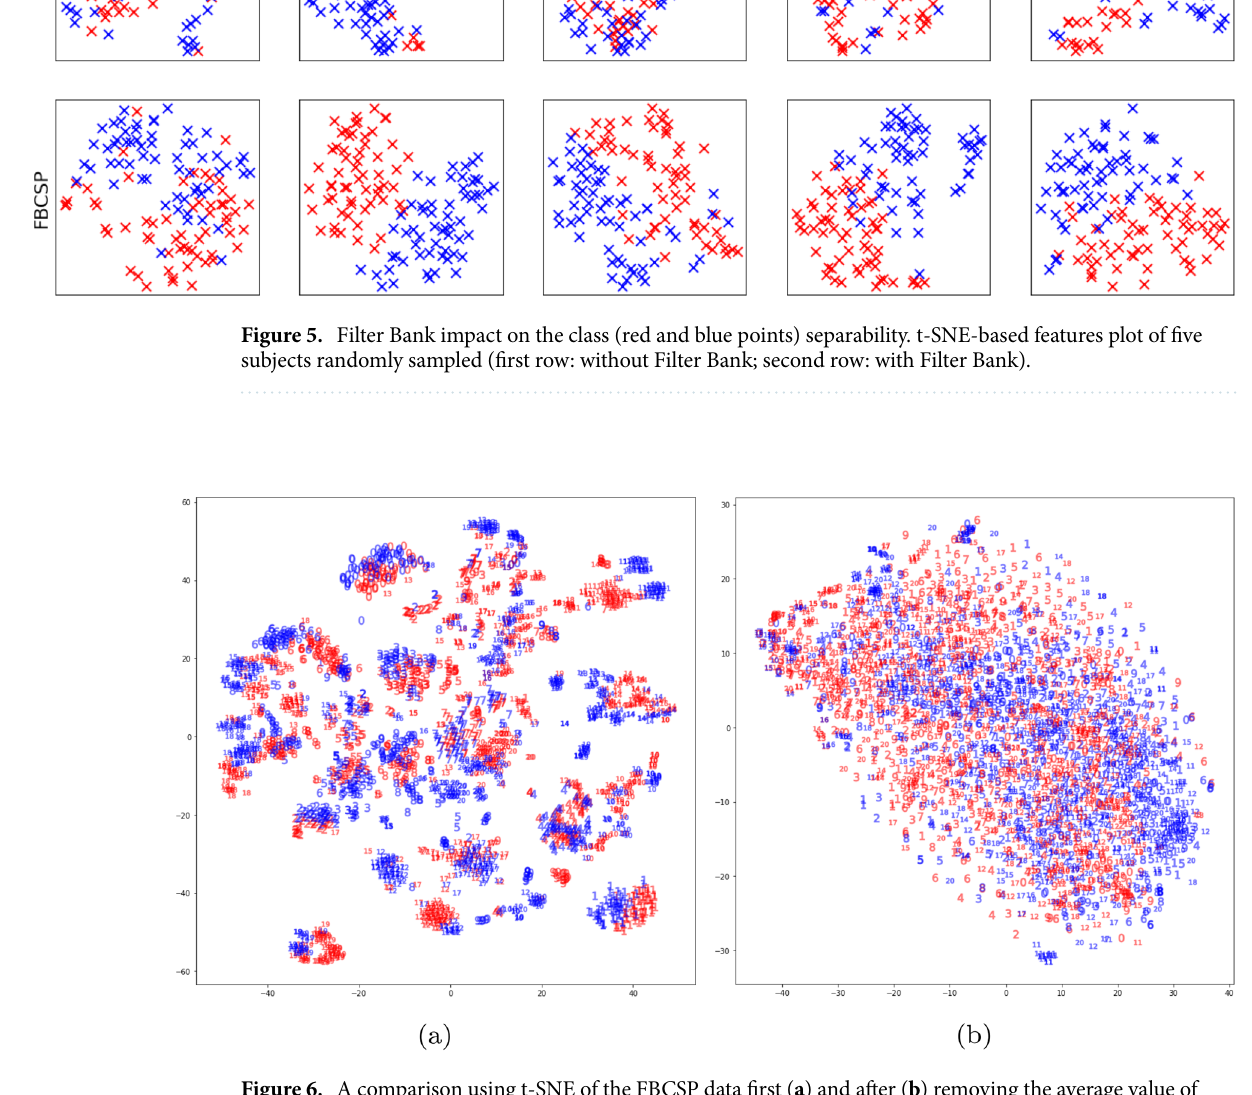
Figure 6. A comparison using t-SNE of the FBCSP data first ( a ) and after ( b ) removing the average value of each subject, in the cross-subject approach. The colors (red and blue) correspond to the two classes, the numbers identify the